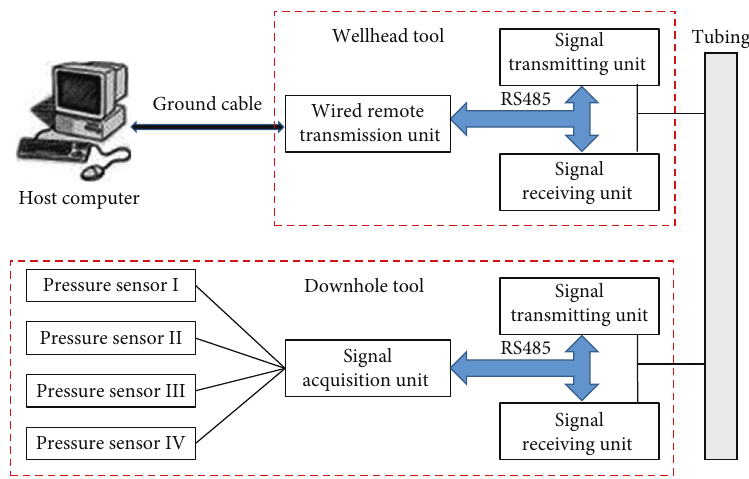
Figure 5: Circuit diagram of downhole pressure wireless monitoring system.